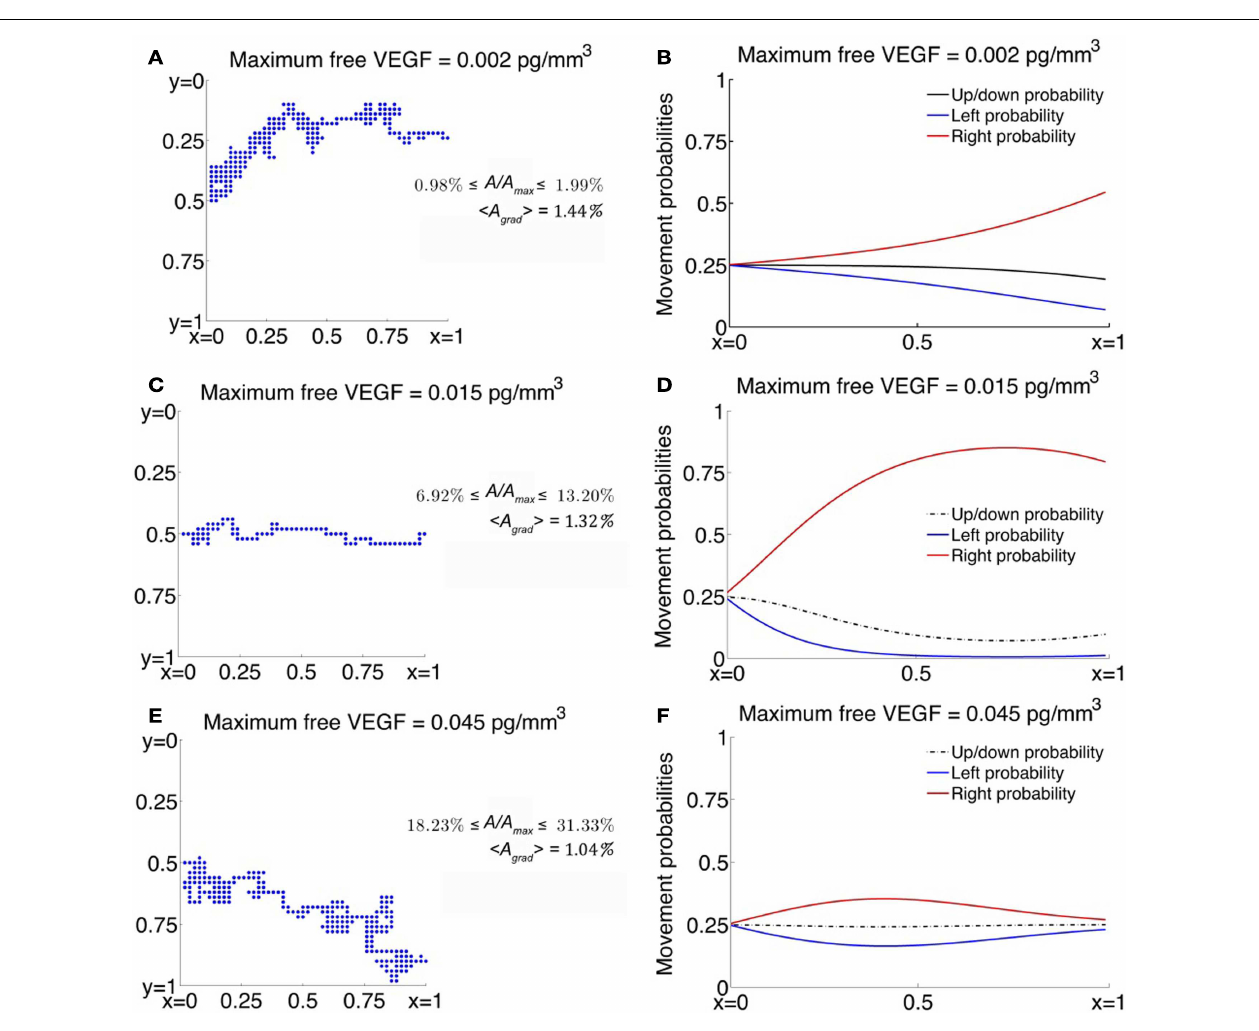
per cell face expressed here as a percentage, and < A grad > represents the gradient of A across a cell length, averaged over the entire domain. (B,D,F) Corresponding movement probabilities for various values of maximumVEGF